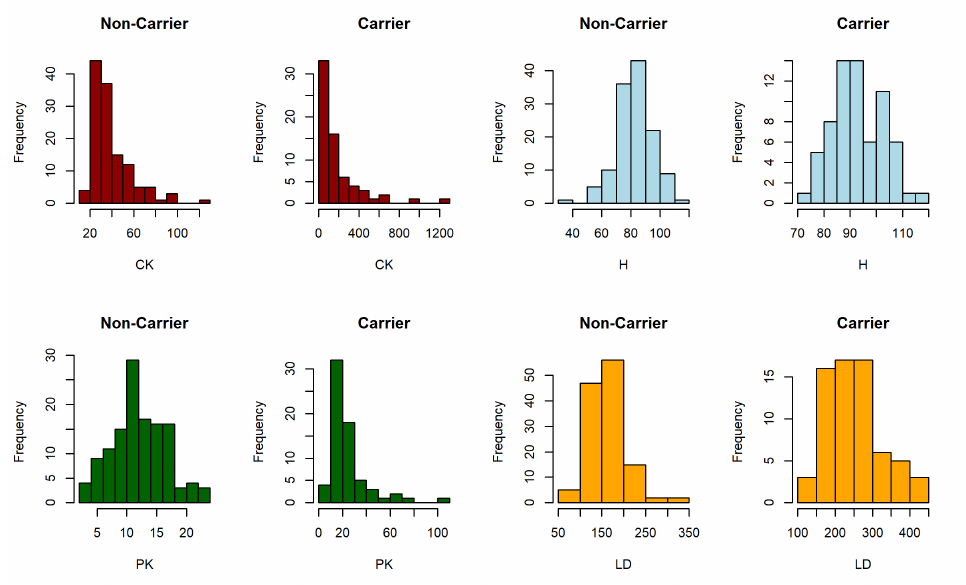
Figure 1. Marginal distributions of biomarkers. DMD dataset. CK: serum creatine kinase, H: haemopexin, PK: pyruvate kinase, LD: lactate